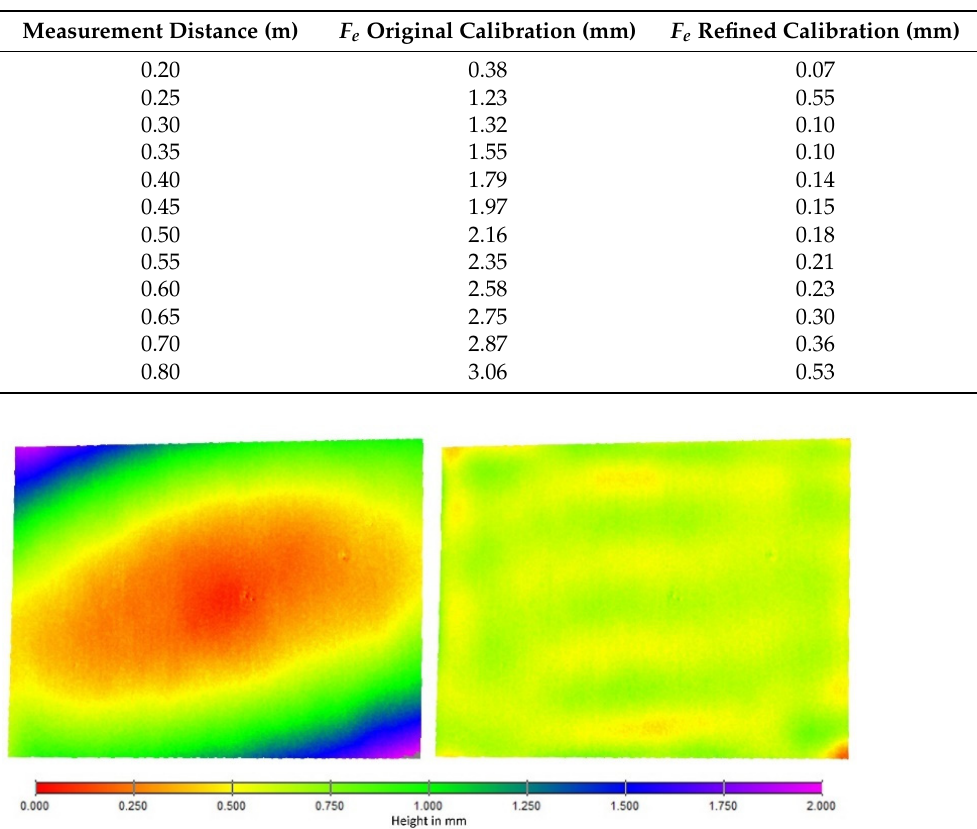
Figure 9. Example of a plane measurement at distance of 400 mm. False color representation with initial (left) and refined (right) calibration.